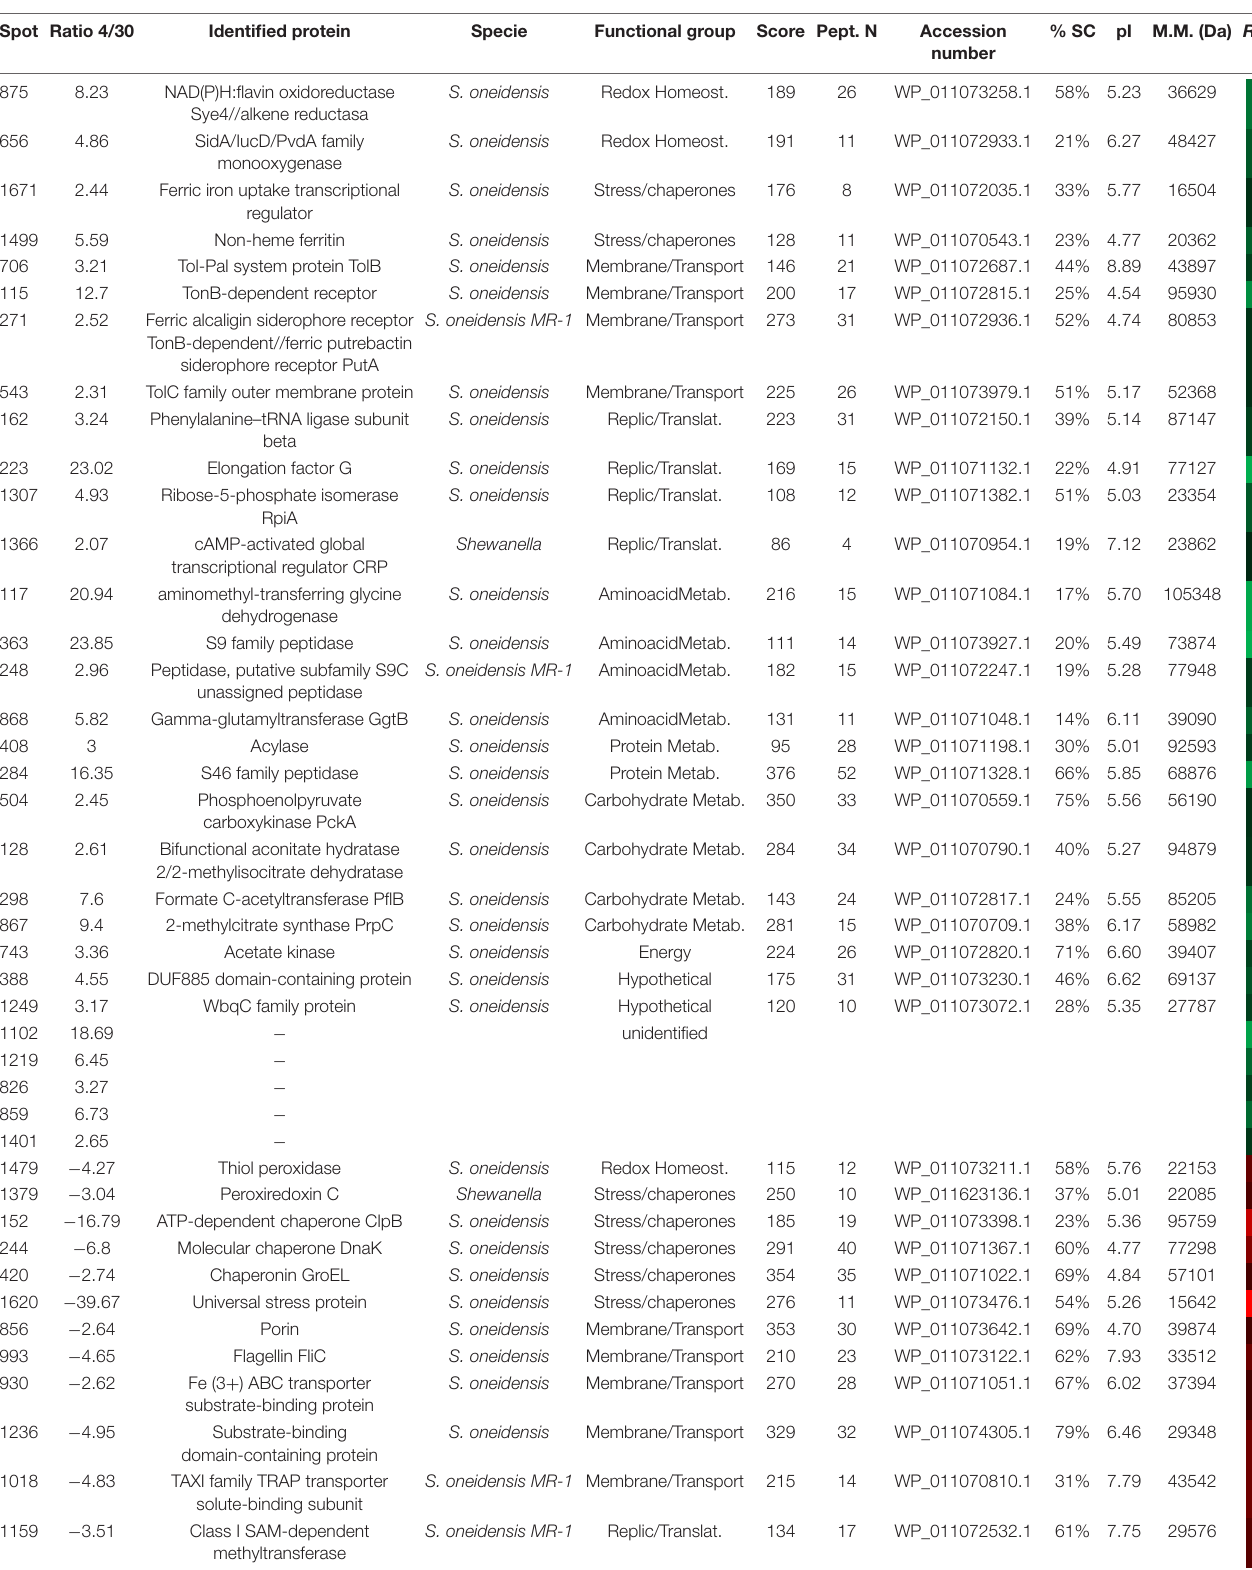
TABLE 5 | Identified proteins in S. oneidensis overexpressed at 4 (green) and 30 ◦ C (red). Spot Ratio 4/30 Identified protein Specie Functional group Score Pept.